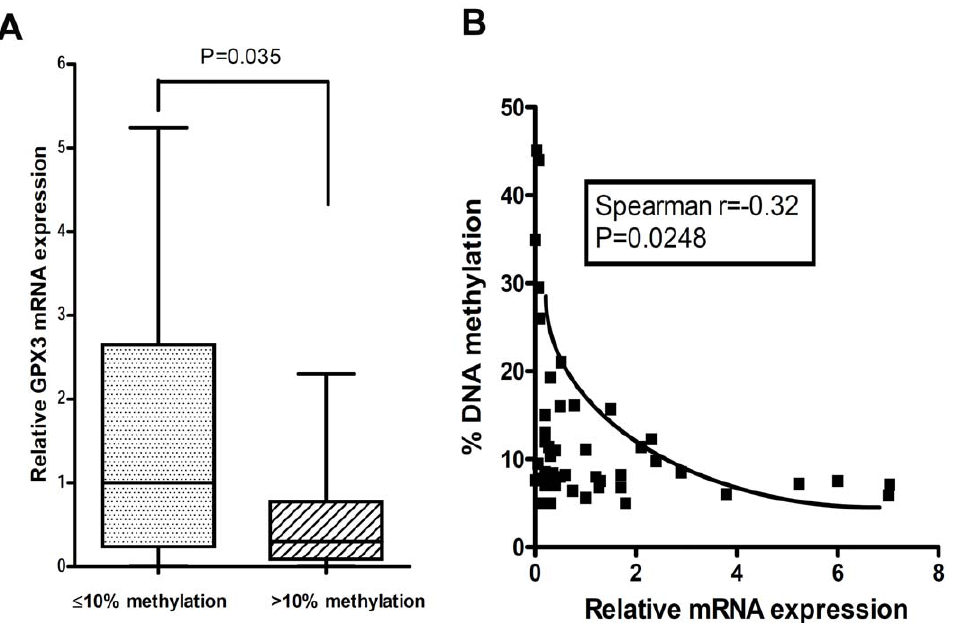
Figure 3. GPX3 promoter methylation level inversely correlates with GPX3 gene expression. (A) GPX3 expression level in gastric cancers with GPX3 hypermethylation ( $ 10%) was significantly lower than that in gastric cancers without hypermethylation ( , 10%). (B) Spearman analysis of all normal and tumor samples with GPX3 gene expression and DNA methylation demonstrated a significant inverse correlation(r= 2 0.32) between DNA hypermethylation and gene expression.